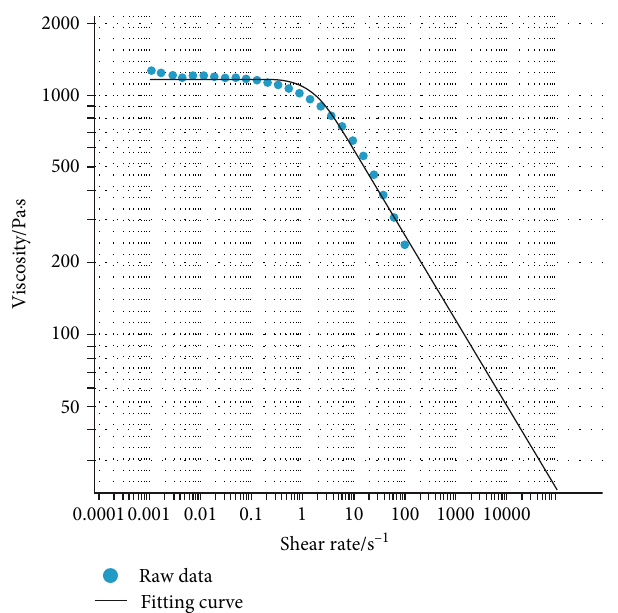
Figure 4: The fitting curve of PP melt under the Bird–Carreau